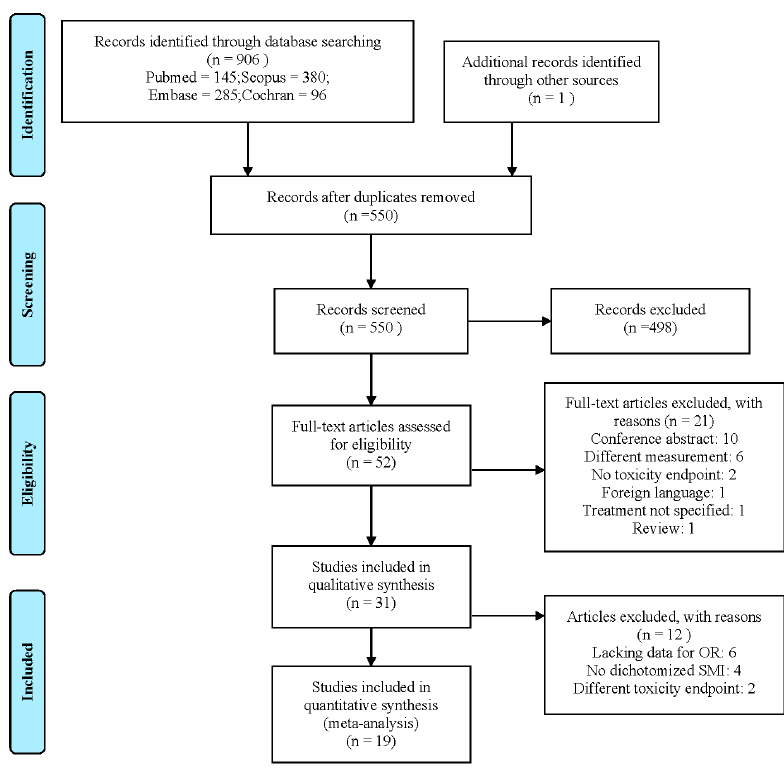
Figure 1. Preferred Reporting Items for Systematic reviews and Meta-analyses (PRISMA) flowchart detailing the study selection process.